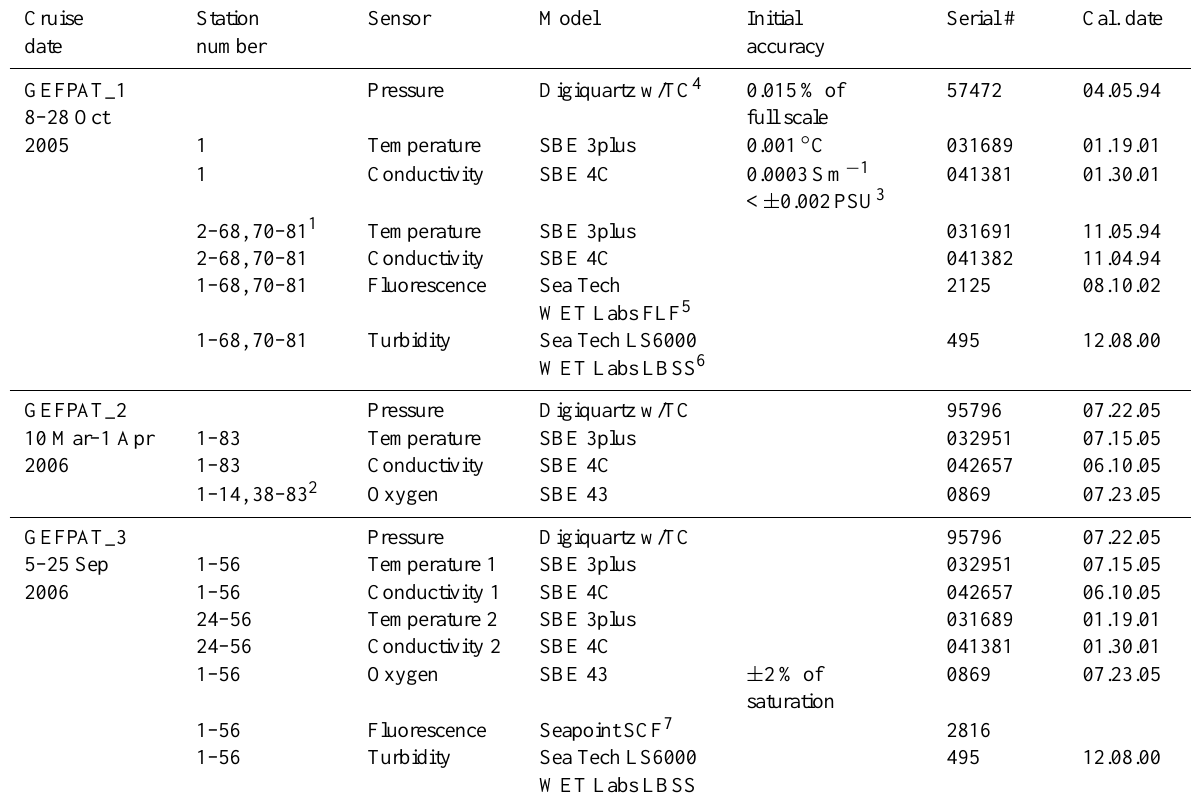
Table 1. Summary of CTD sensors used in GEF Patagonia